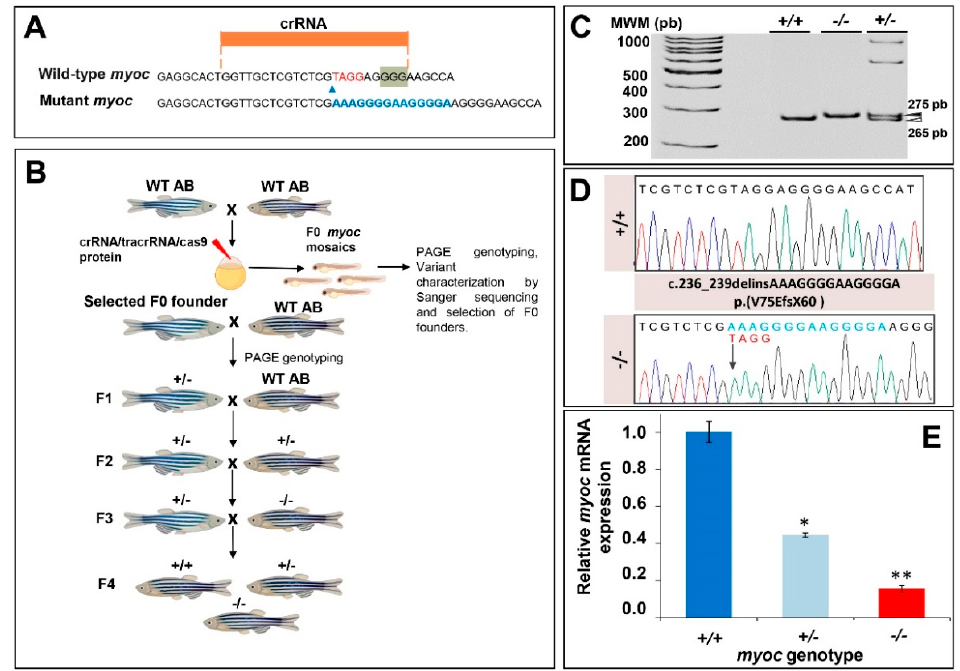
Figure 1. Generation and molecular characterisation of a myoc KO zebrafish line using CRISPR/Cas9 genome editing. ( A ) Localisation of the crRNA designed to target myoc exon 1. The PAM sequence is indicated on a green background. Red and blue nucleotides indicate deleted and inserted nucleotides identified in mutant fishes used to establish the KO line, respectively. ( B ) Stepwise procedure that was followed to establish the KO line. F0 animals were raised to adulthood, crossed with wild-type AB zebrafish and the offspring was genotyped by PAGE to identify germline transmission of myoc deletions (F0 founders). F0 founders were crossed with wild-type AB animals to obtain mutant F1 heterozygotes that were further outbred to segregate off-targets mutations and to obtain the F2 generation. F2 heterozygotes were inbred to produce the F3 generaton. The Biorender tool was used to create this scheme. ( C ) Genotyping of a myoc indel using 8% PAGE. Three representative samples are shown. White arrowhead: wild-type allele (265 bp). Black arrowhead: mutant allele (275 bp). ( D ) Sanger sequencing of the selected myoc mutation. The arrow in the electropherogram indicate the nucleotide where the mutation starts. Blue and red letters indicate inserted (14 bp) and deleted (4 bp) nucleotides, respectively. ( E ) Decreased myoc mRNA levels in myoc mutant zebrafish (+/ − and − / − ). mRNA levels in pools of 15 F3 zebrafish larvae (144 hpf) were measured by qRT-PCR. The results are expressed as relative expression levels and normalised to control wild-type (+/+) larvae. Values represent the average of three different experiments. Asterisks indicate statistical significance compared to +/+. * p = 00051. ** p =0.00017.